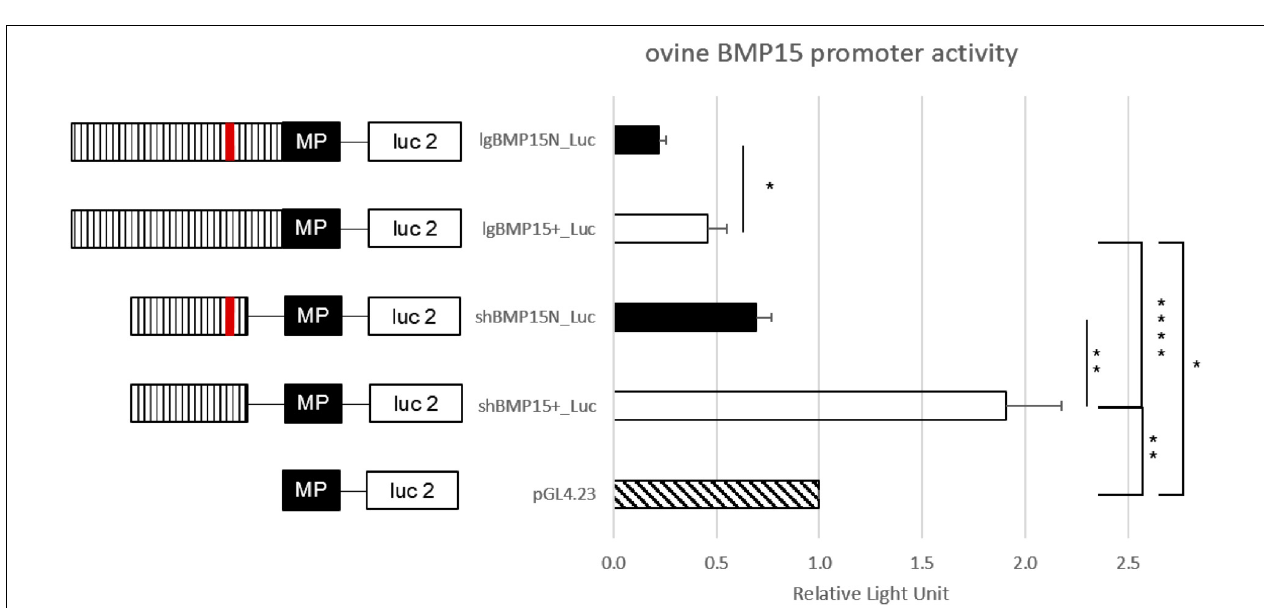
FIGURE 7 | Functional effect of FecX N mutation on the BMP15 promoter activity. In vitro reporter luciferase assay from CHO cells transiently transfected with empty vector or wild-type BMP15 promoter (BMP15 + ) or mutant BMP15 promoter (BMP15 N ). Two fragments were generated, a long (lg) form of 732 bp (-743, -11 bp referring to ATG start codon) and a short (sh) form of 341 bp (-443, -102 bp). Results are expressed as means ± SEM of the relative light unit (RLU) from six independent transfection experiments in triplicate. Asterisk indicates significant difference after one-way ANOVA * P < 0.05; ** P < 0.01; **** P < 0.0001. MP, minimal promotor of pGL4.23; Luc 2, luciferase reporter gene; hatched bar, BMP15 promotor; red line, FecX N